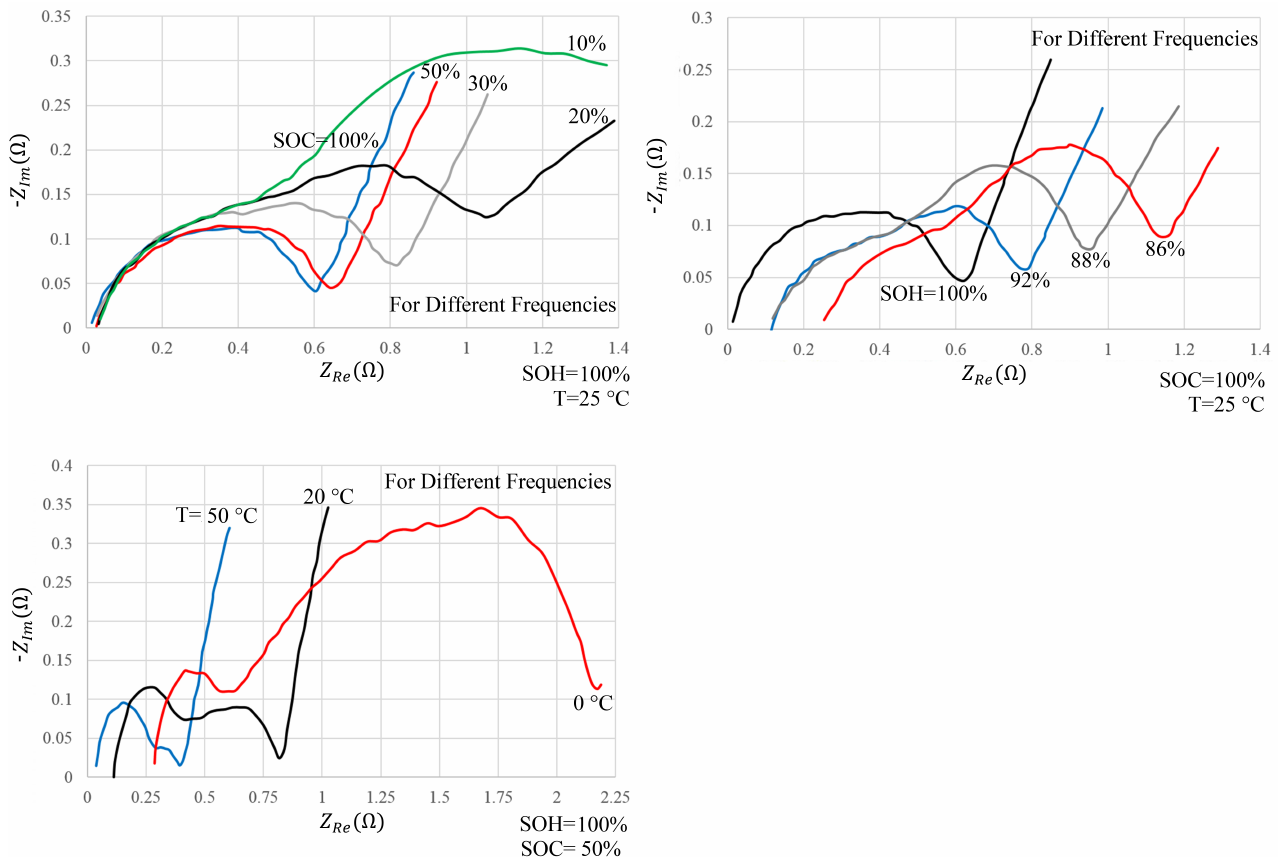
Figure 11. The effect of temperature (T), state of health (SOH), and state of charge (SOC) on the real and imaginary parts of the AC impedance of a Li-ion battery